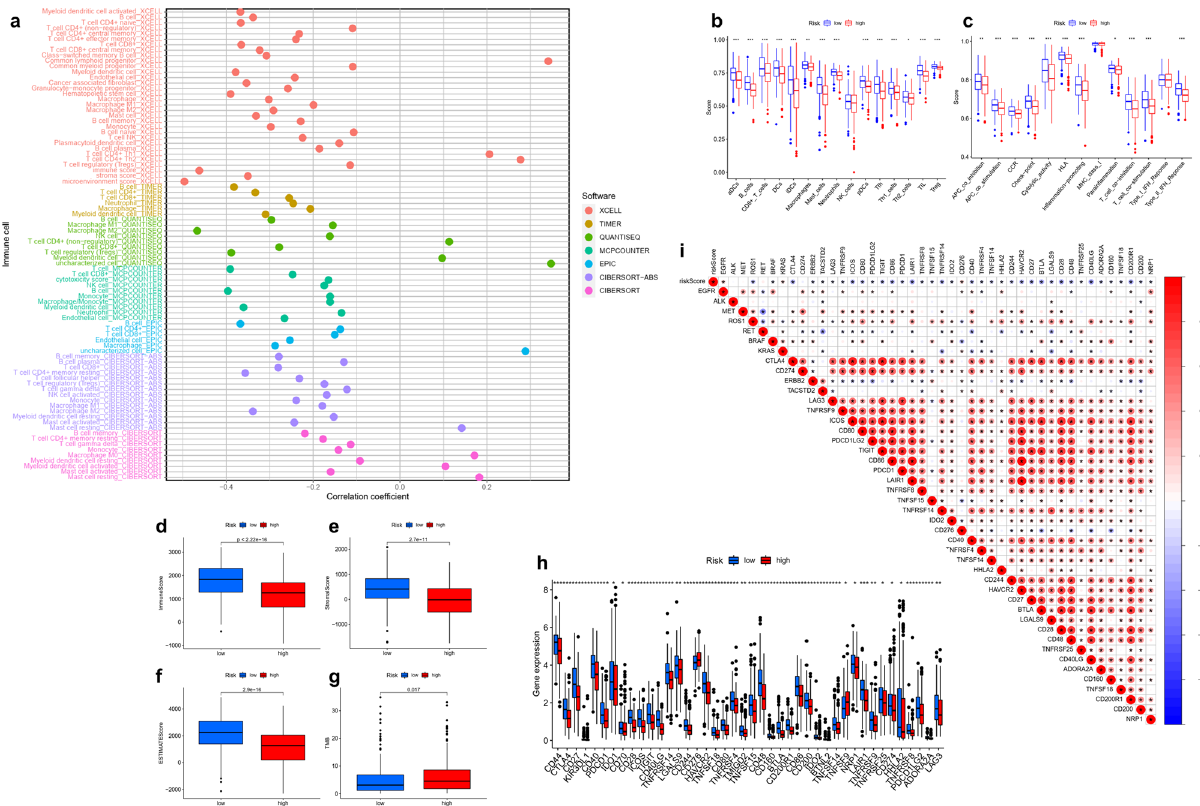
Figure 5. Immune characteristics in the HRG and LRG. ( a ) The bubble chart shows the relationship between RS and immune cells. The ssGSEA analysis for immune cell infiltration ( b ) and immune function ( c ) in the HRG and LRG. ( d ) Immune cell scores in the HRG and LRG. ( e ) Stromal cell scores in the HRG and LRG. ( f ) ESTIMATE scores in the HRG and LRG. ( g ) TMB of the HRG and LRG. ( h ) The difference in the expression of immune checkpoint molecules in the HRG and LRG. ( i ) Correlation between RS and the expression of representative genes for